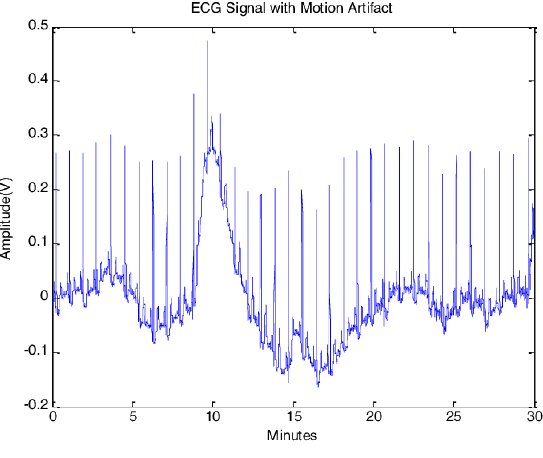
Figure 11. ECG Motion